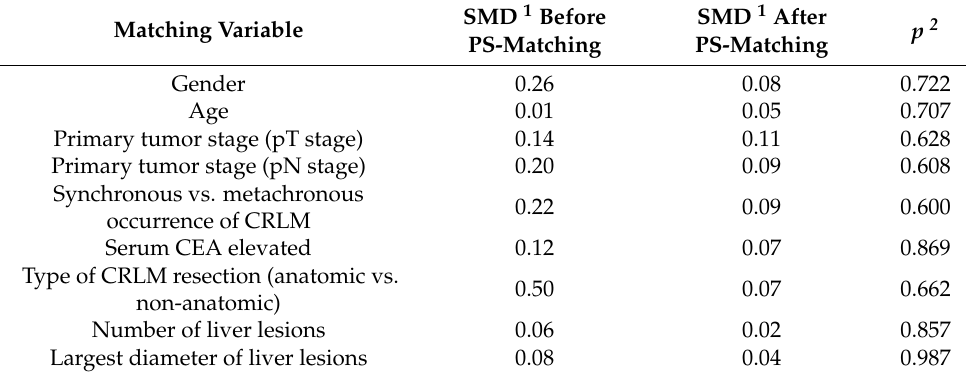
Table 3. Results of propensity-score matching.